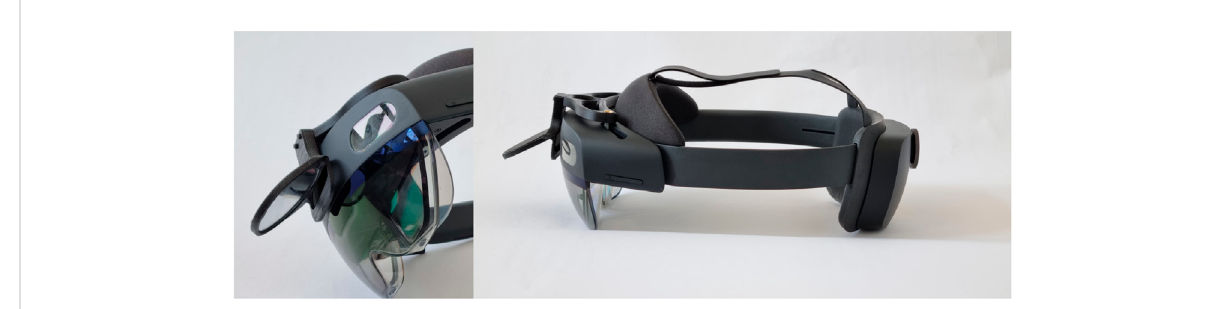
FIGURE 1 MirrorModuleattachedtoHL2.Themirrorisattachedwithanangleof30 ° .TheupperpartoftheAHATsensoriscoveredtoeliminatere fl ections in the mirror. The spacing between mount and HL2 allows heat dissipation.